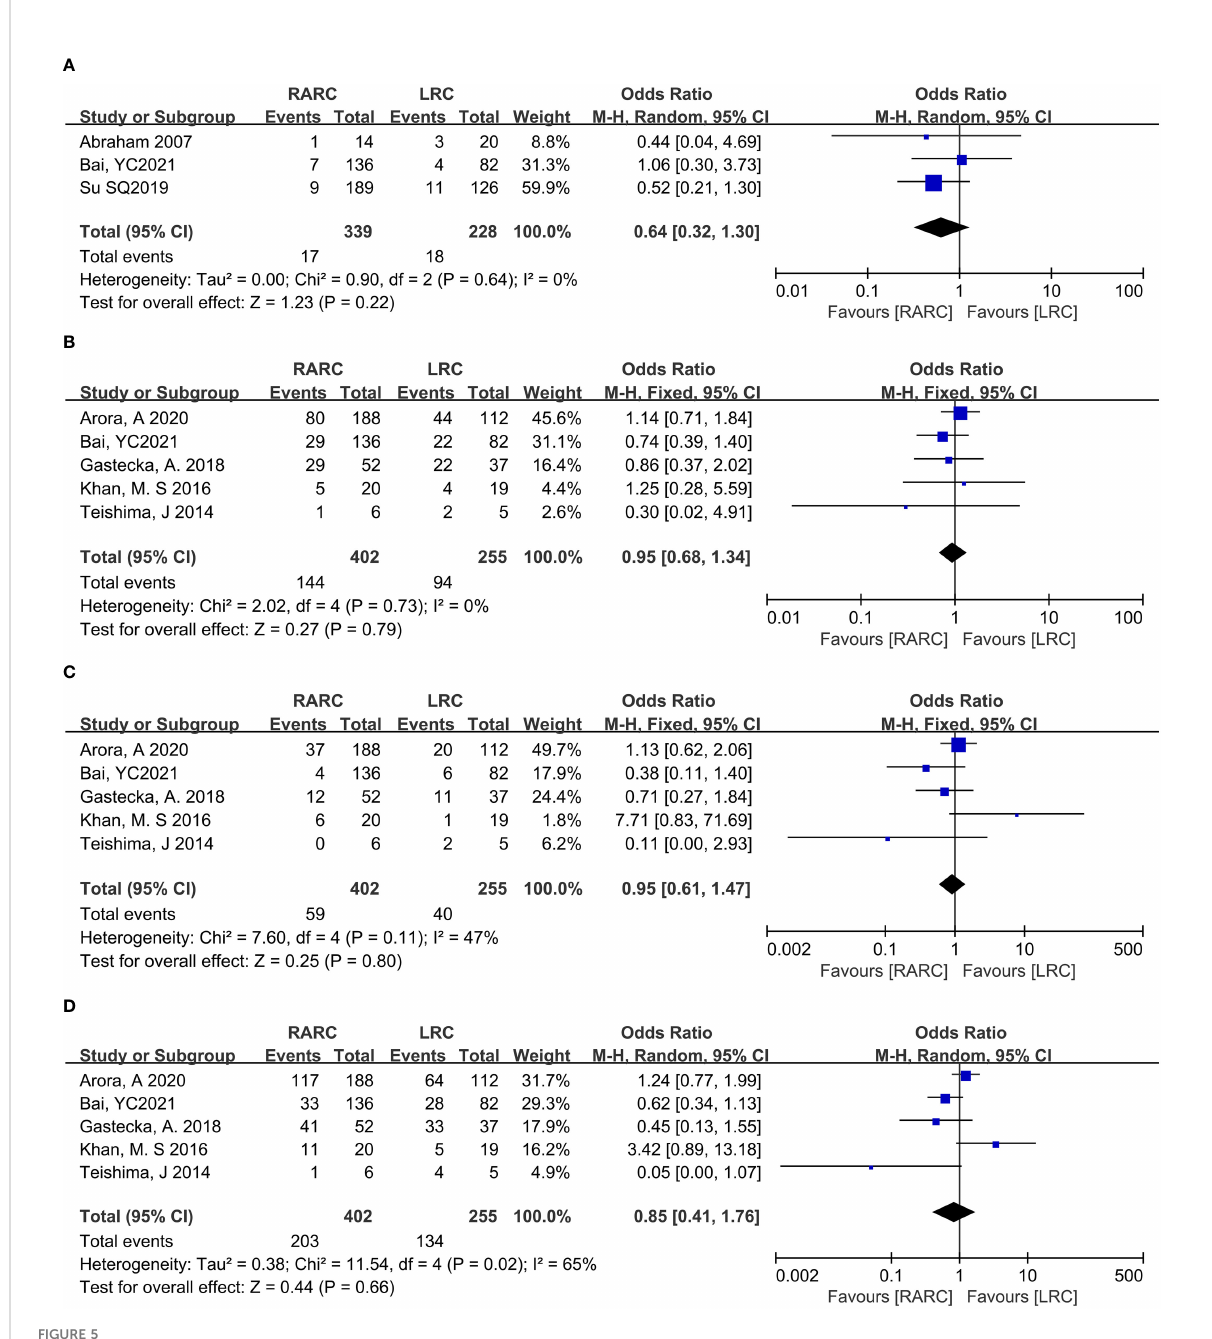
FIGURE 5 Forest plot of RARC versus LRC on (A) Intraoperative complication, (B) Postoperative complication Grade ≤ II within 30 days, (C) Postoperative complication Grade ≥ III within 30 days, and (D) Early complications within 30